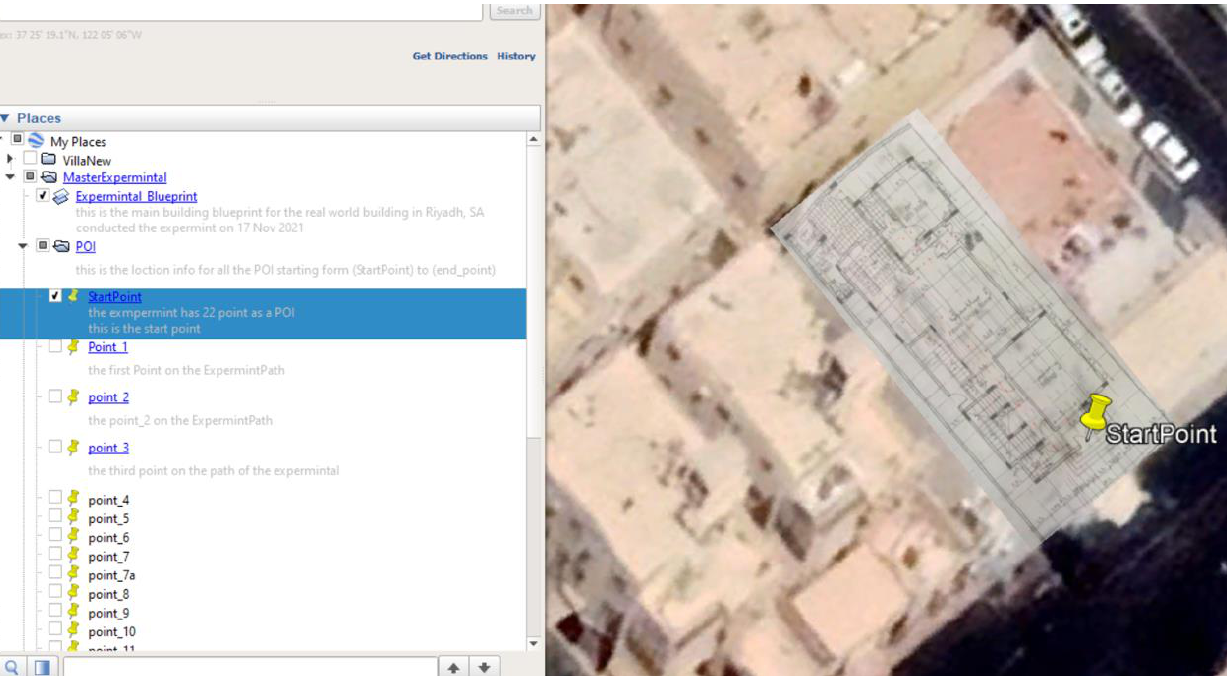
Figure 25. Georeferenced blueprint of the building.